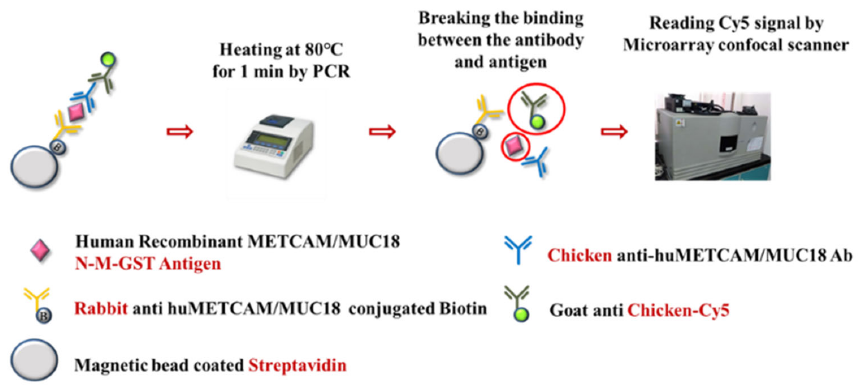
Figure 4. The procedure of MBIA [43]. The large circle indicates the released Cy5-conjugated goat anti-chicken and the small circle indicates the released antigen after